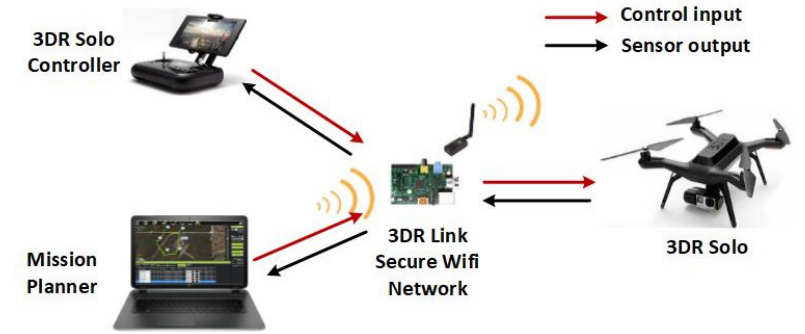
Figure 8. System